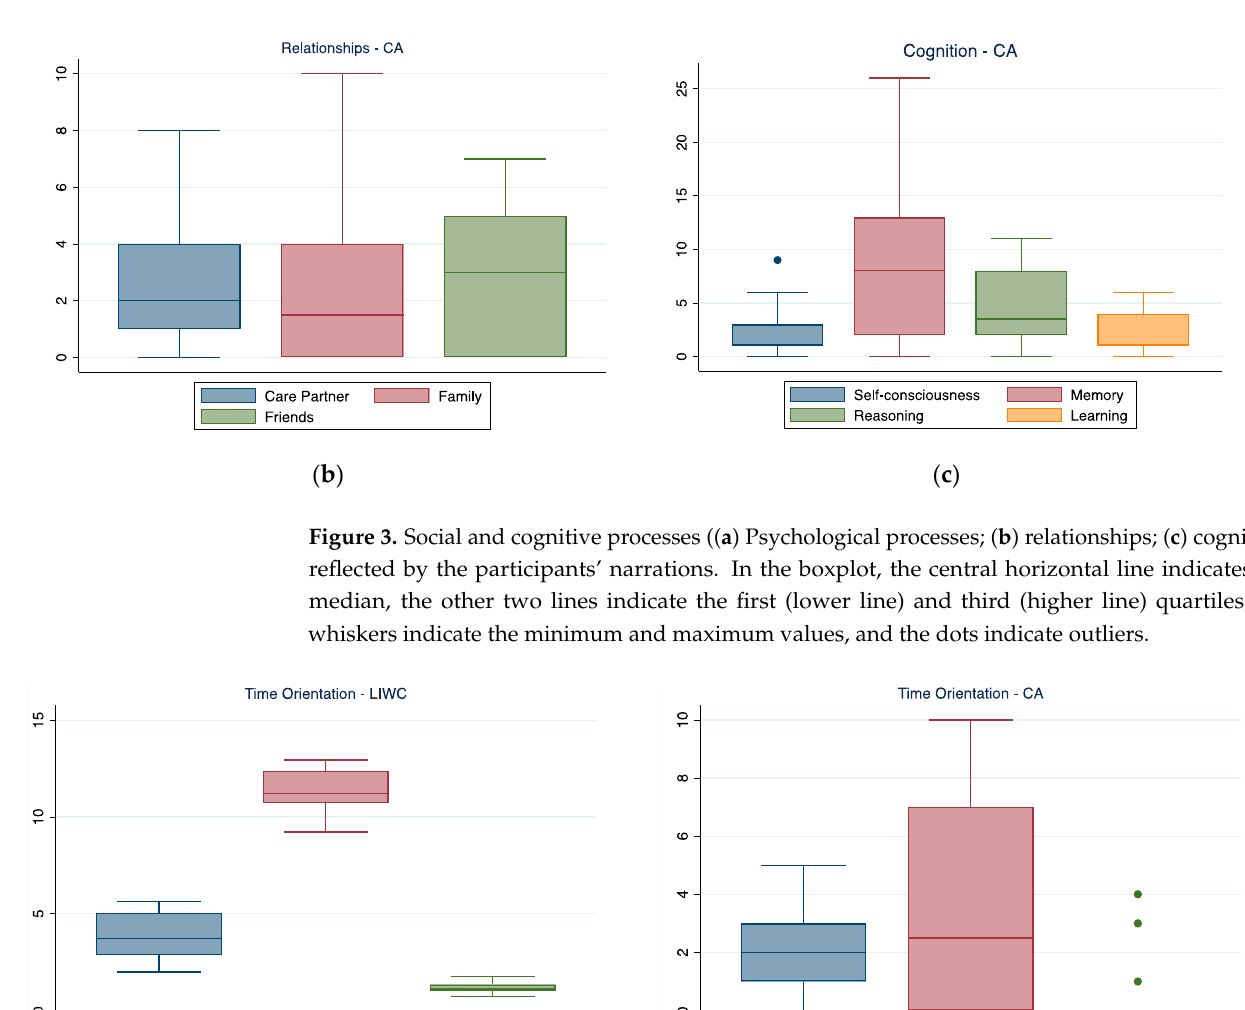
Figure 5. The focus on Movement for Parkinson’s. In the boxplot, the central horizontal line indi- cates the median, the other two lines indicate the first (lower line) and third (higher line) quartiles, the whiskers indicate the minimum and maximum values, and the dots indicate outliers.